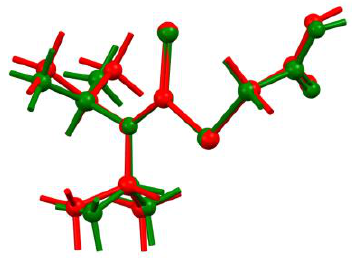
Figure 5. An overlay diagram of the experimental (green image) and optimized molecules (red).